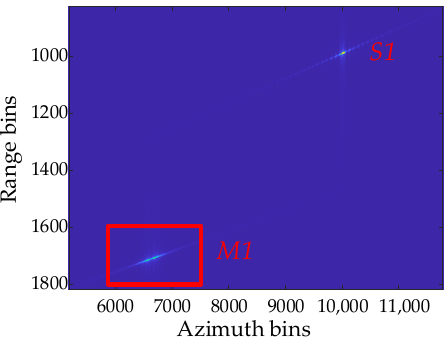
Figure 8. Conventional RMA imaging results of point targets.